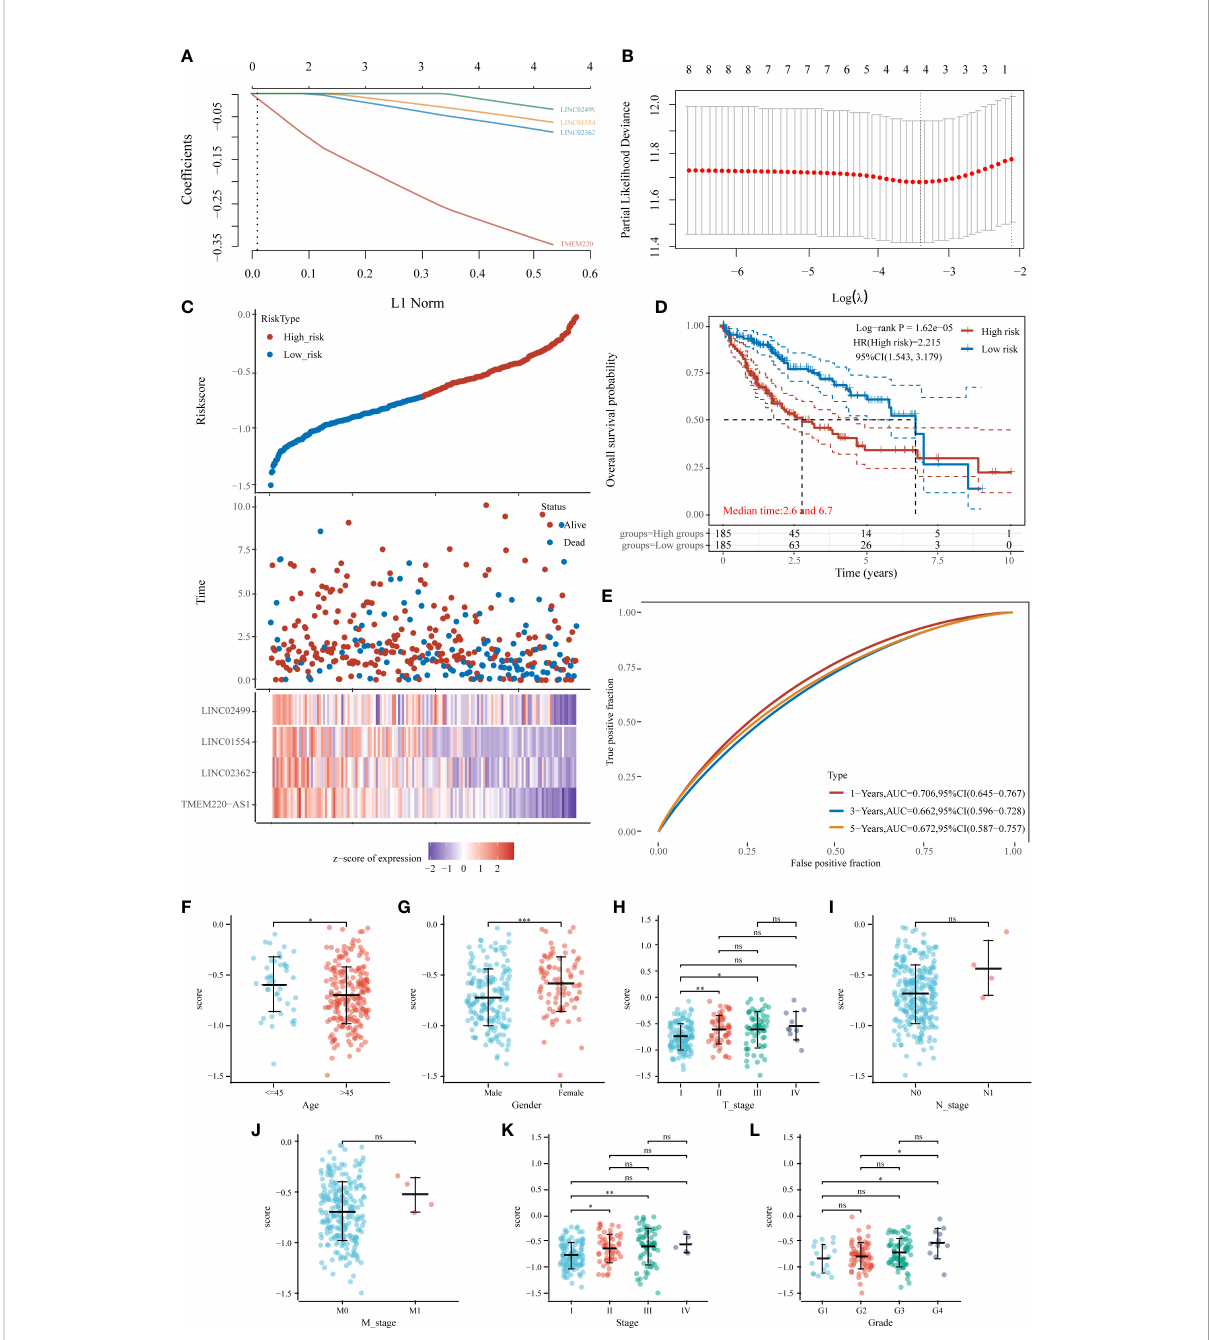
FIGURE 7 Prognostic model of HCC based on 20 IICDLs. (A) LASSO coef fi cient pro fi les of the four IICDLs. (B) A plot of the error rates from ten-fold cross-validation. (C) An overview of the risk score distribution, survival status of each patient, and a heat map of four IICDLs. (D) KM survival curve illustrating the predictive value of the risk model. (E) ROC curve of the predictive value of the risk model. Correlations between risk score and age (F) , sex (G) , T stage (H) , N stage (I) , M stage (J) , clinical stage (K) , and grade (L) . (*P < 0.05; **P < 0.01; ***P < 0.001; ns, not signi fi